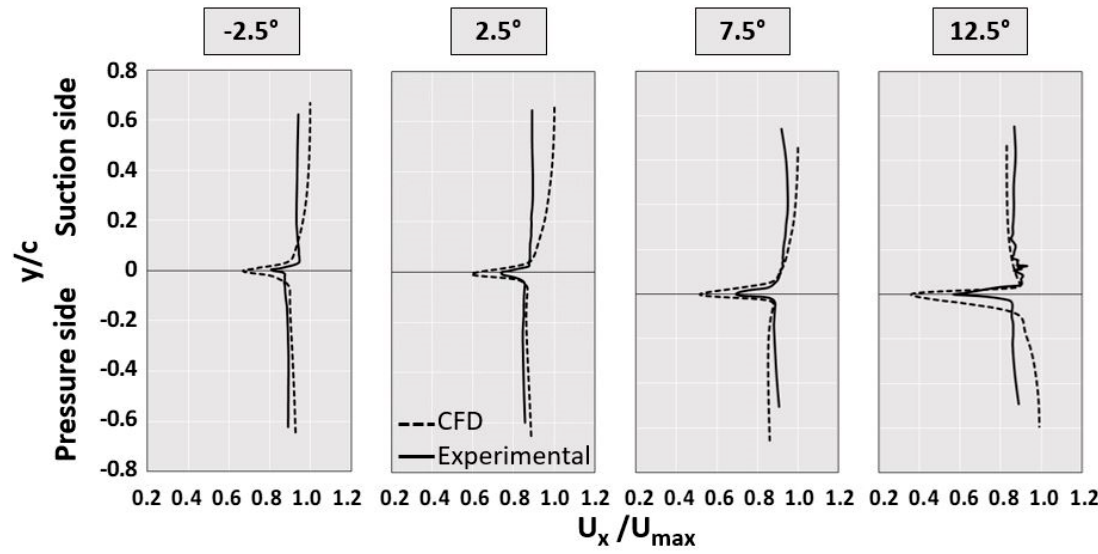
Figure 7. Comparison between numerical and experimental results for the transversal distributions of streamwise velocity at different angles of attack.